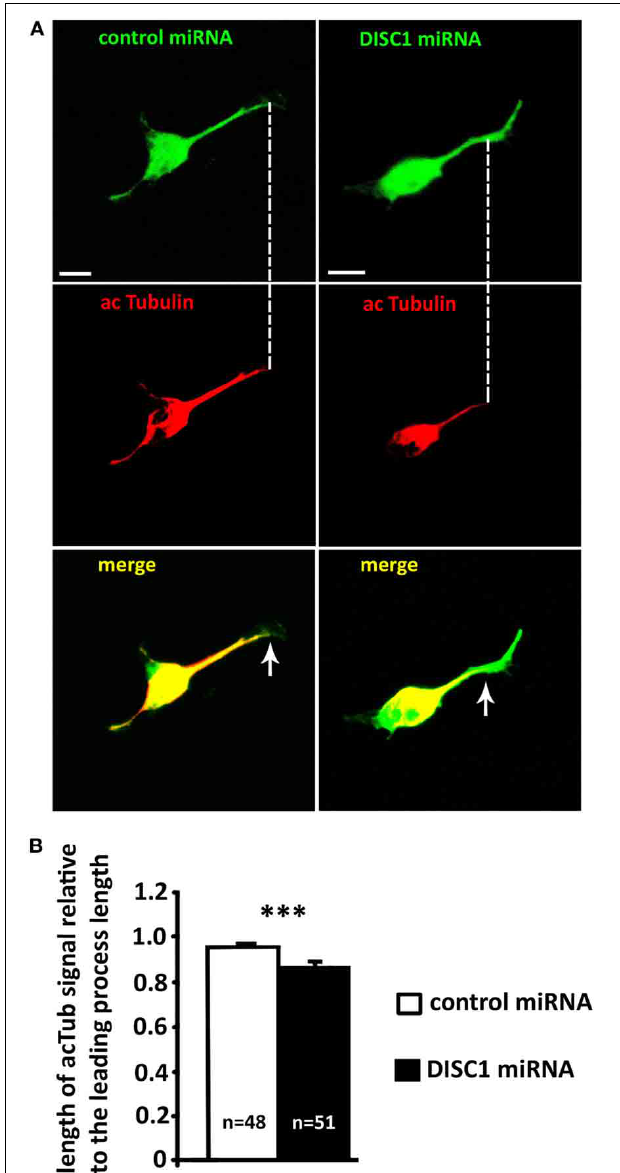
FIGURE 8 | Knockdown of DISC1 affects microtubule acetylation in the leading process of migrating interneurons. (A) Fluorescence micrographs of control and DISC1 miRNA expressing interneurons immunostained against acetylated Tubulin (acTub). Arrows display the end of the acTub expression in the leading processes. Scale bars: 5 μ m. (B) Analysis of the acTub signal in the leading process relative to the leading process length. DISC1 knockdown resulted in a decreased length of acTub compared to control cells. Student’s t -test: ∗∗∗ p < 0 . 001. Error bars: s.e.m. “n” reflects number of